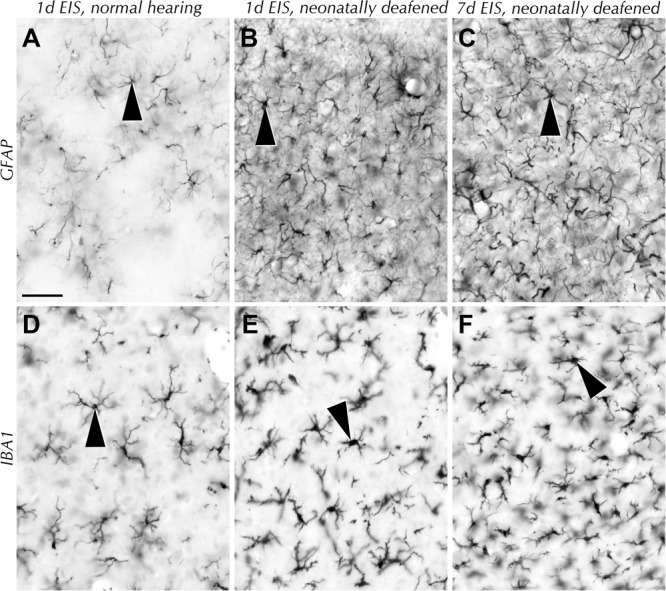
Glial cell populations in CIC after contralateral EIS. (A) In hearing-experienced rats, EIS did not induce changes in intensity and pattern of astrocyte density and arborization (arrowhead) compared to controls. (B) In deafened rats, 1 d EIS caused a dramatic increase in density of the dendritic network formed by hypertrophic astrocytes (arrowhead). (C) By 7 d EIS of deaf rats, hypertrophic astrocytes (arrowhead) still form a dense network with their processes. (D) In hearing-experienced rats, no changes were seen in the staining of microglial cells (arrowhead) after EIS of any duration. (E) In deaf rats, microglia (arrowhead) became stout and have retracted fine processes by 1 d EIS. (F) By 7 d EIS of deaf rats, microglia (arrowhead) have begun to extend fine processes again, increasing the density of the network. Scale bar: 50 μm.